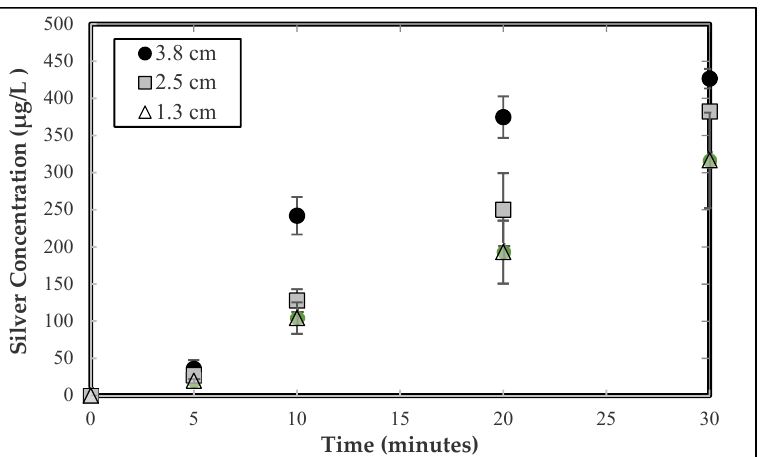
trendline is included for each ionic strength to depict the linear relationship of metal ion release and time.